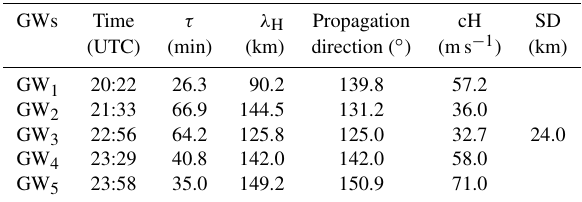
Table 1. The observed properties of the five